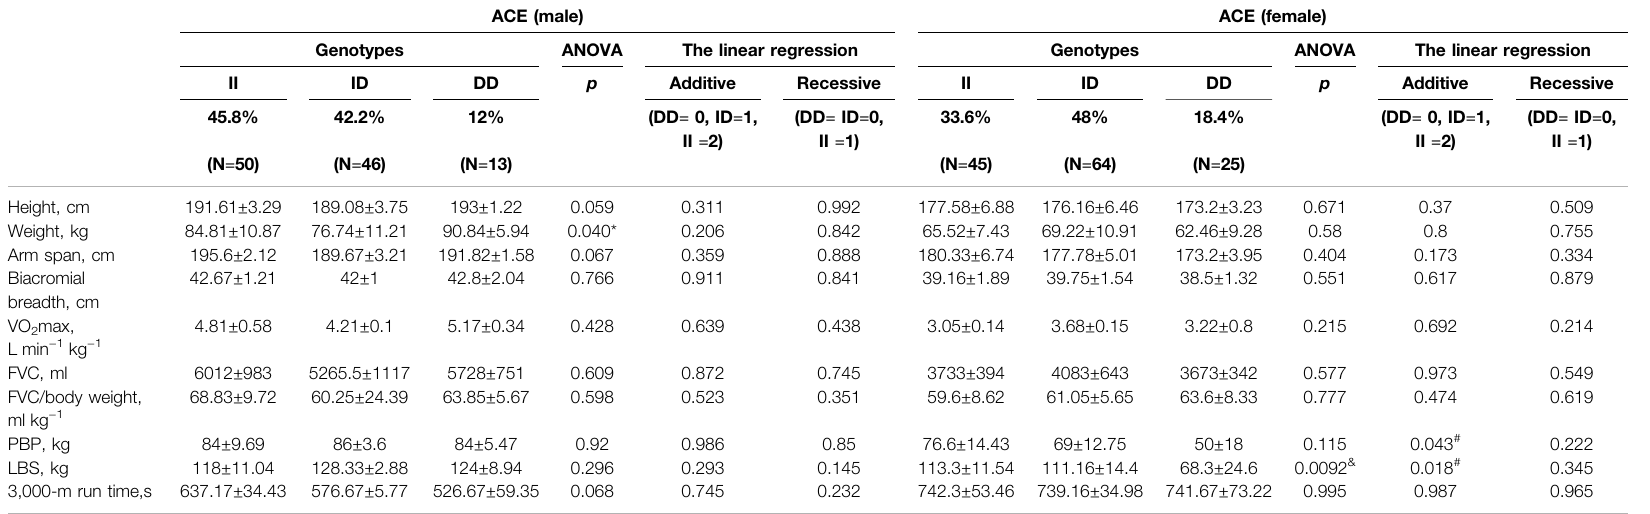
TABLE 2 | The ACE I/D genotype and distribution in rowing athletes showing the related anthropometric, physical and strength-trait variables.